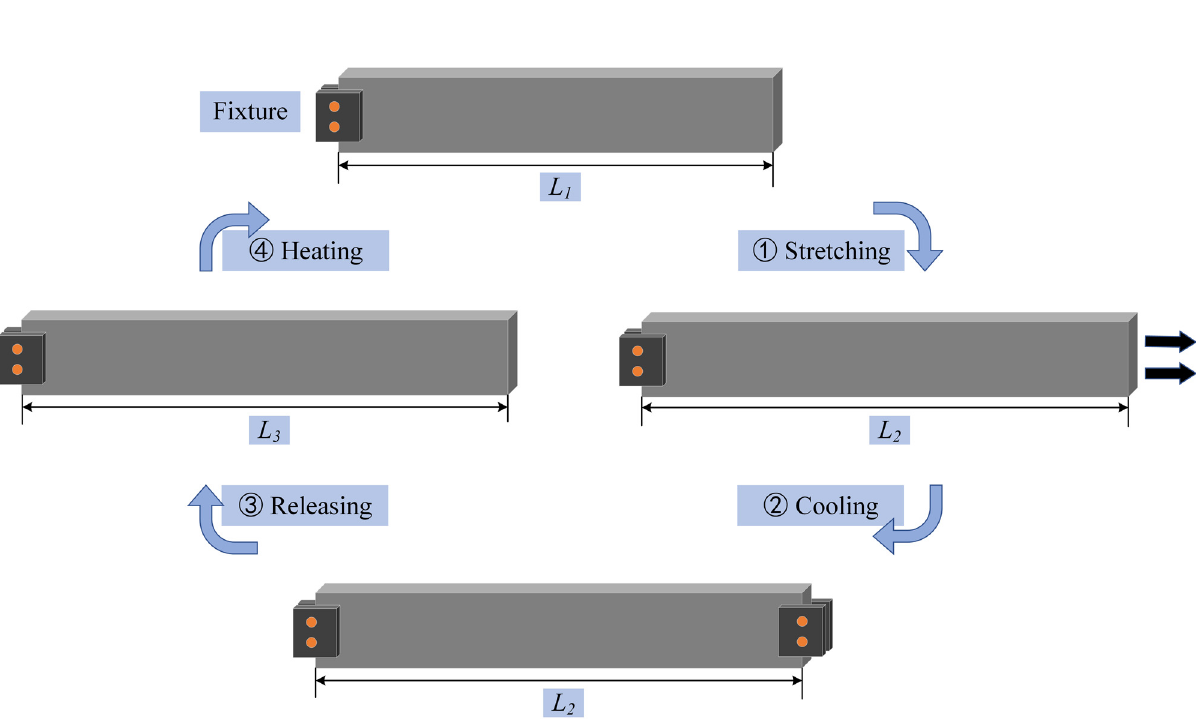
Figure 6: Schematic of shape memory process: ( 1 ) stretch 5 mm above the glass transition temperature with a speed of 0.5 mm/s; ( 2 ) cool down at a speed of 0.9°C/s and maintain a strain of 5 mm; ( 3 ) remove the displacement load; and ( 4 ) heat at a speed of